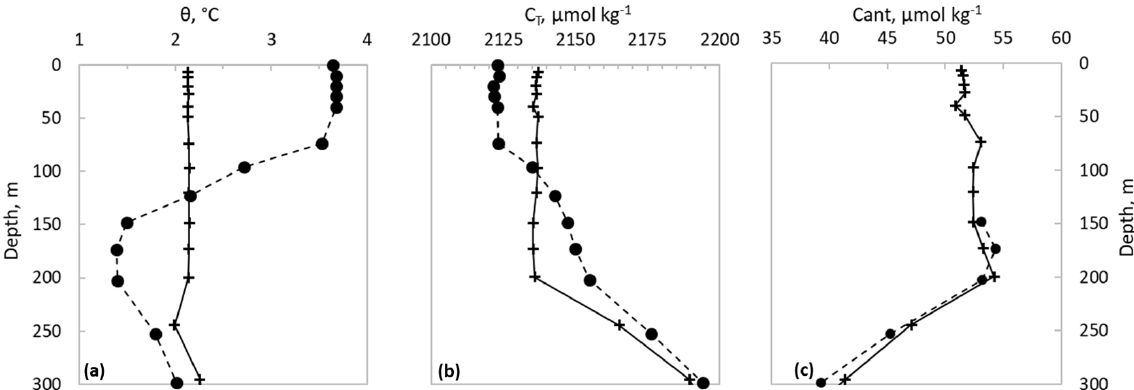
Figure 3. Vertical profiles of (a) potential temperature, (b) C T and (c) C ant (TrOCA method) for two seasons: during winter (July 2000, cross) and summer (January 2001, circle) at Station O10. The C ant concentrations for each year were estimated just below the summer mixed layer. Note that C ant during summer in the upper layer is uncertain (results not shown) but below 125m C ant in summer should correspond to C ant in